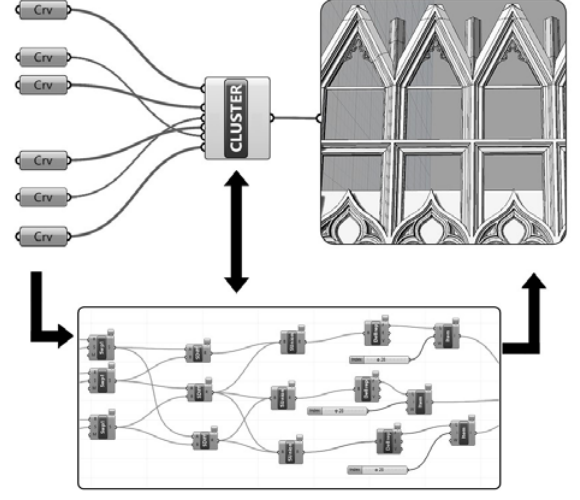
Figure 8. The workflow in Grasshopper to build a “falconatura”. Obtaining the section of the elements (input CRV) from the survey data and the final model (output) through a series of commands that together compose the